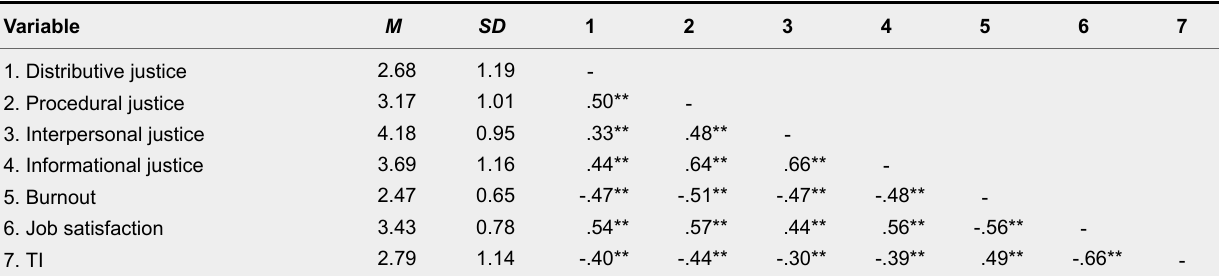
Descriptive Statistics and Bivariate Correlations Between the Variables Under Study (n = 408)